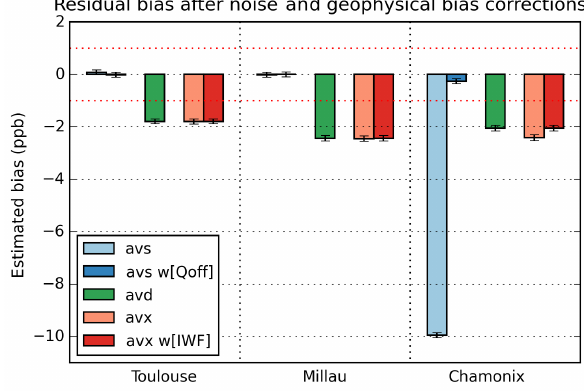
Figure 11. Residual bias after statistical bias correction for the three studied averaging schemes (red dotted lines: targeted bias ± 1ppb).